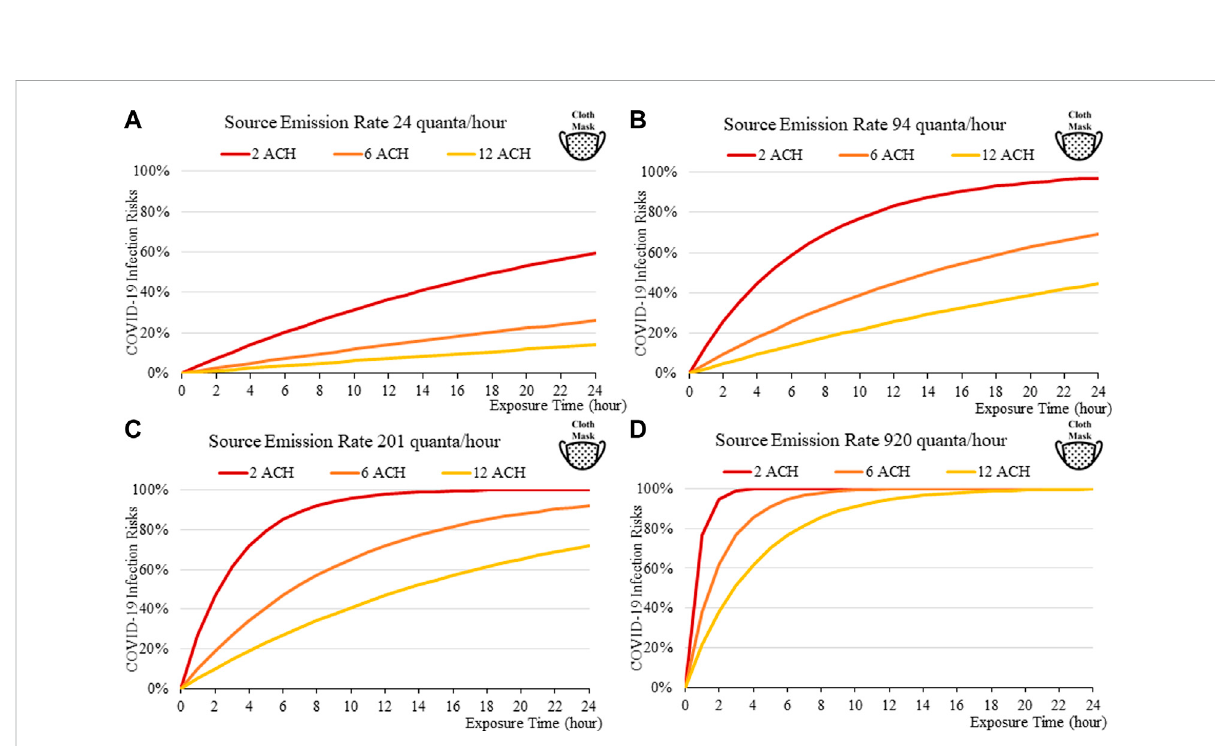
FIGURE 11 Disease infection risks for the Omicron variant, assuming the receiver and index patient are both wearing a cloth face mask (40% and 50% Inward and Outward Filtration Ef fi ciencies): Assuming the exhale quanta emission rate of 24 (A) , 94 (B) , 201 (C) , and 920 (D) quanta/hour for the